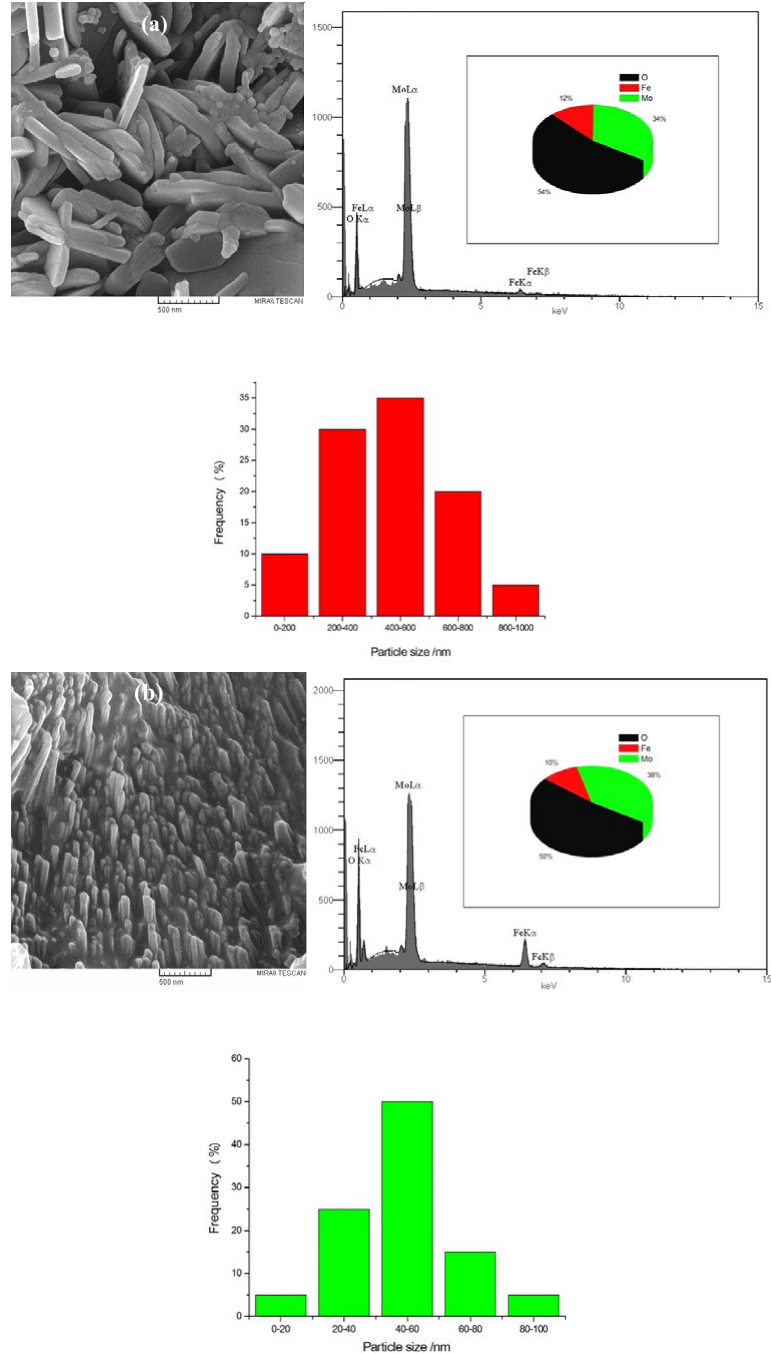
Fig. 1: SEM images of (a) Fe-MoI, (b) Fe-MoII and (c) Fe-MoIII and EDX accomplished by the size distribution histogram of the prepared